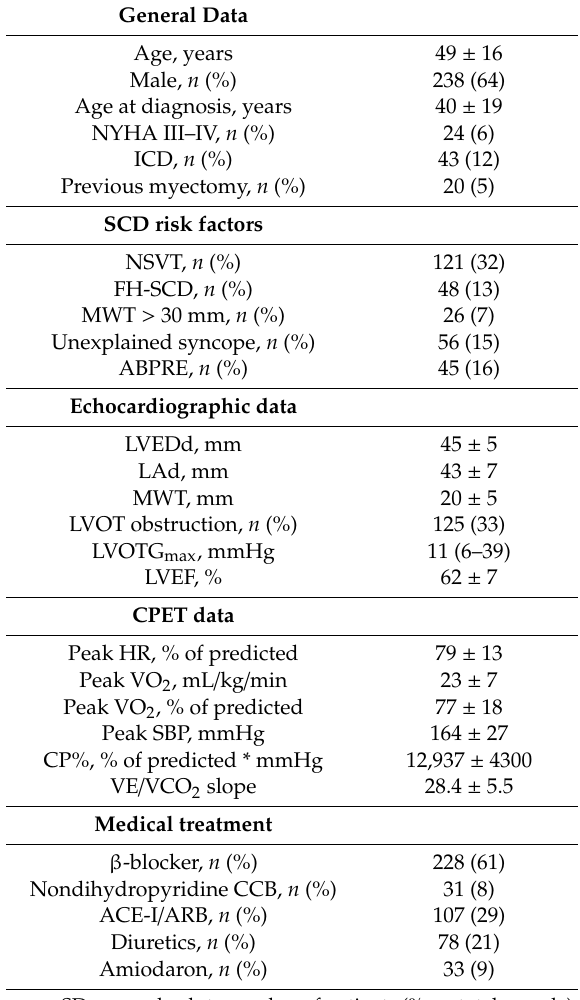
Table 1. Main clinical variables of the entire study sample at the study run-in ( n = 371